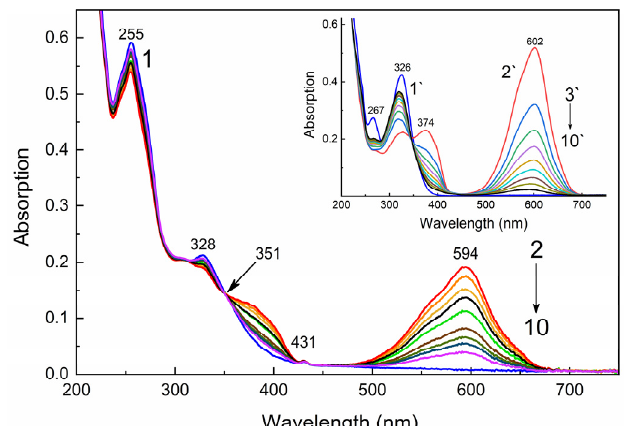
Figure 1. Absorption spectra of 2 (curve 1) and 2 ′ (curves 2–10) measured before (1) and upon UV ‐ irradiation (2) through a UFS ‐ 1 light filter and during bleaching in the dark (3–10). The inset shows the absorption spectra of 1 (curve 1 ′ ) and 1 ′ (curves 2 ′ –10 ′ ). The arrow indicates the position of the isosbestic point. C = 10 − 4 M, L = 0.1 cm.